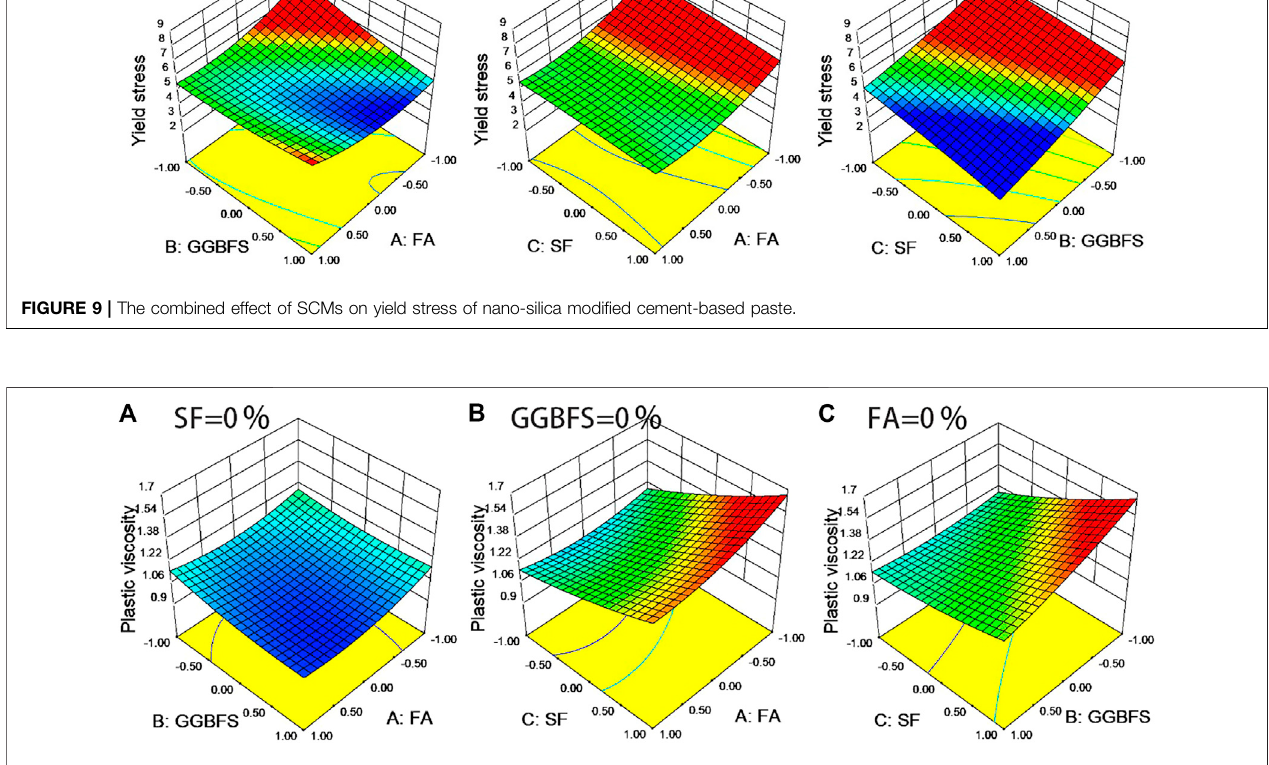
FIGURE 10 | The combined effect of SCMs on plastic viscosity of nano-silica modi fi ed cement-based paste.